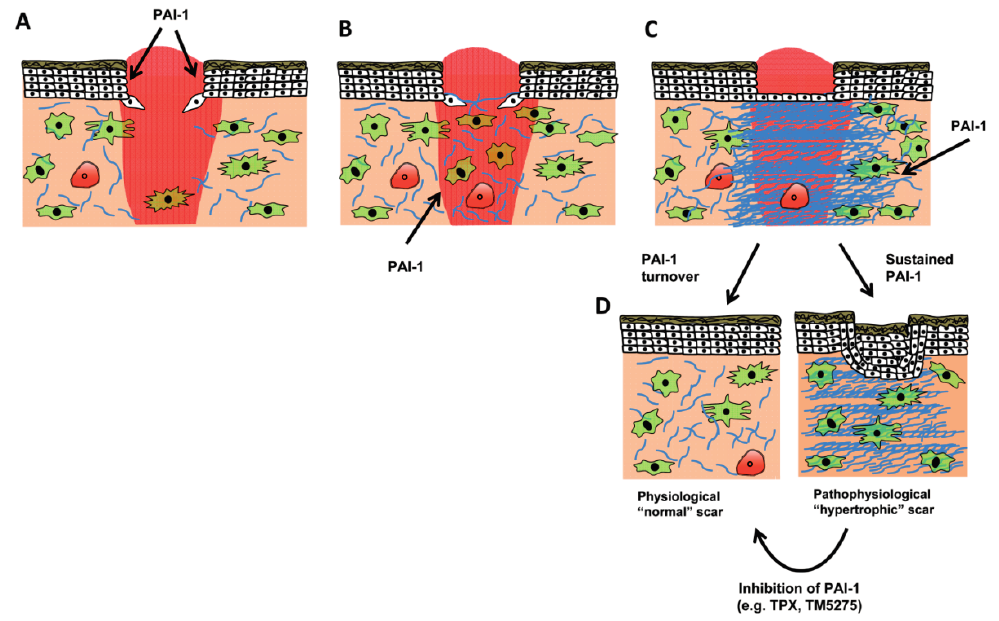
Figure 5. Role of PAI-1 in normal and pathologic wound repair. ( A ) Following injury, a proliferative phase, characterized by keratinocyte proliferation and migration, serves to preliminarily re-epithelialize the injury site. PAI-1 expression is detectable in both